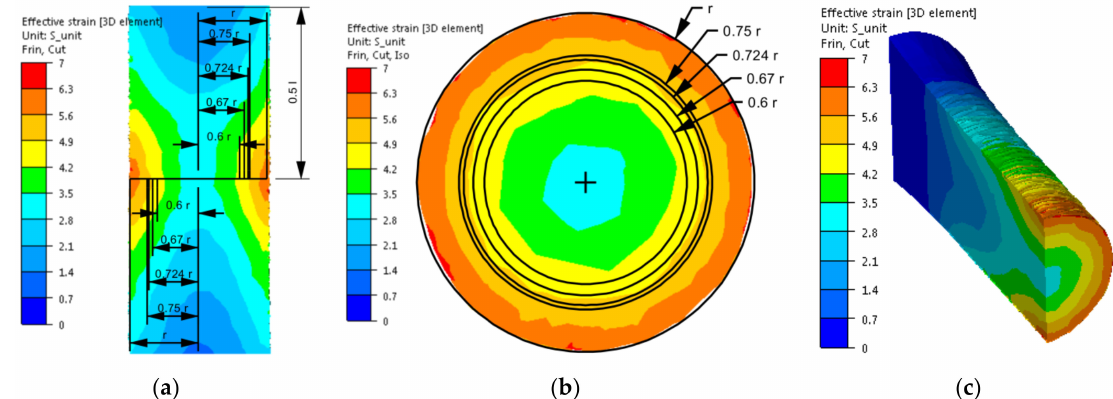
Figure 11. Distribution of the strain intensity of the 5019 aluminium alloy calculated numerically using coefficients from Table 2: ( a ) longitudinal section, ( b ) cross-section—centre of the working part and ( c ) perspective.